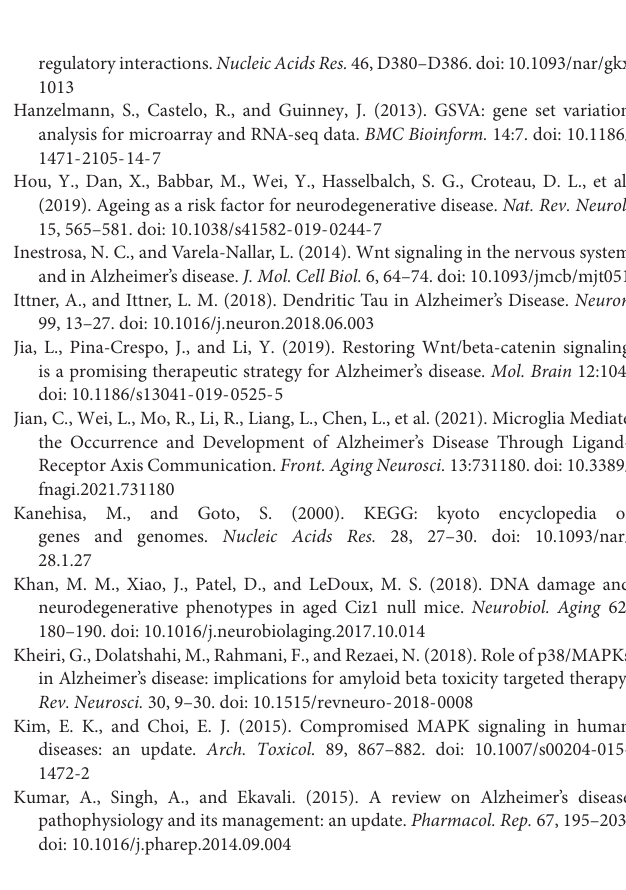
Supplementary Figure 1 | Principal component analysis (PCA) of data and expression of marker genes in different sample modules. (A) PCA of each dataset and platform before removing batch effects. (B) PCA of each dataset and platform after removing batch effects. (C) The expression heat maps of the marker genes of the sample modules in different clusters. Supplementary Figure 2 | Involvement of the marker genes of Alzheimer’s disease modules in various biological processes: (A) module 0, (B) module 1, (C) module 2, (D) module 3, and (E) module 4. Supplementary Figure 3 | Gene set enrichment analysis showing (A) biological processes and (B) pathways enriched in different Alzheimer’s disease sample modules: (a) module 0, (b) module 1, (c) module 2, (d) module 3, and (e) module 4. Supplementary Figure 4 | Validation of the Alzheimer’s disease classifier using an independent dataset. Supplementary Figure 5 | Comparison of age of cellular senescence-type AD samples with other types. Supplementary Table 1 | Clinical information of patient samples included in this study. Supplementary Table 2 | Feature loadings of TOP2 principal components. Supplementary Table 3 | The numbers of each subtype in each data